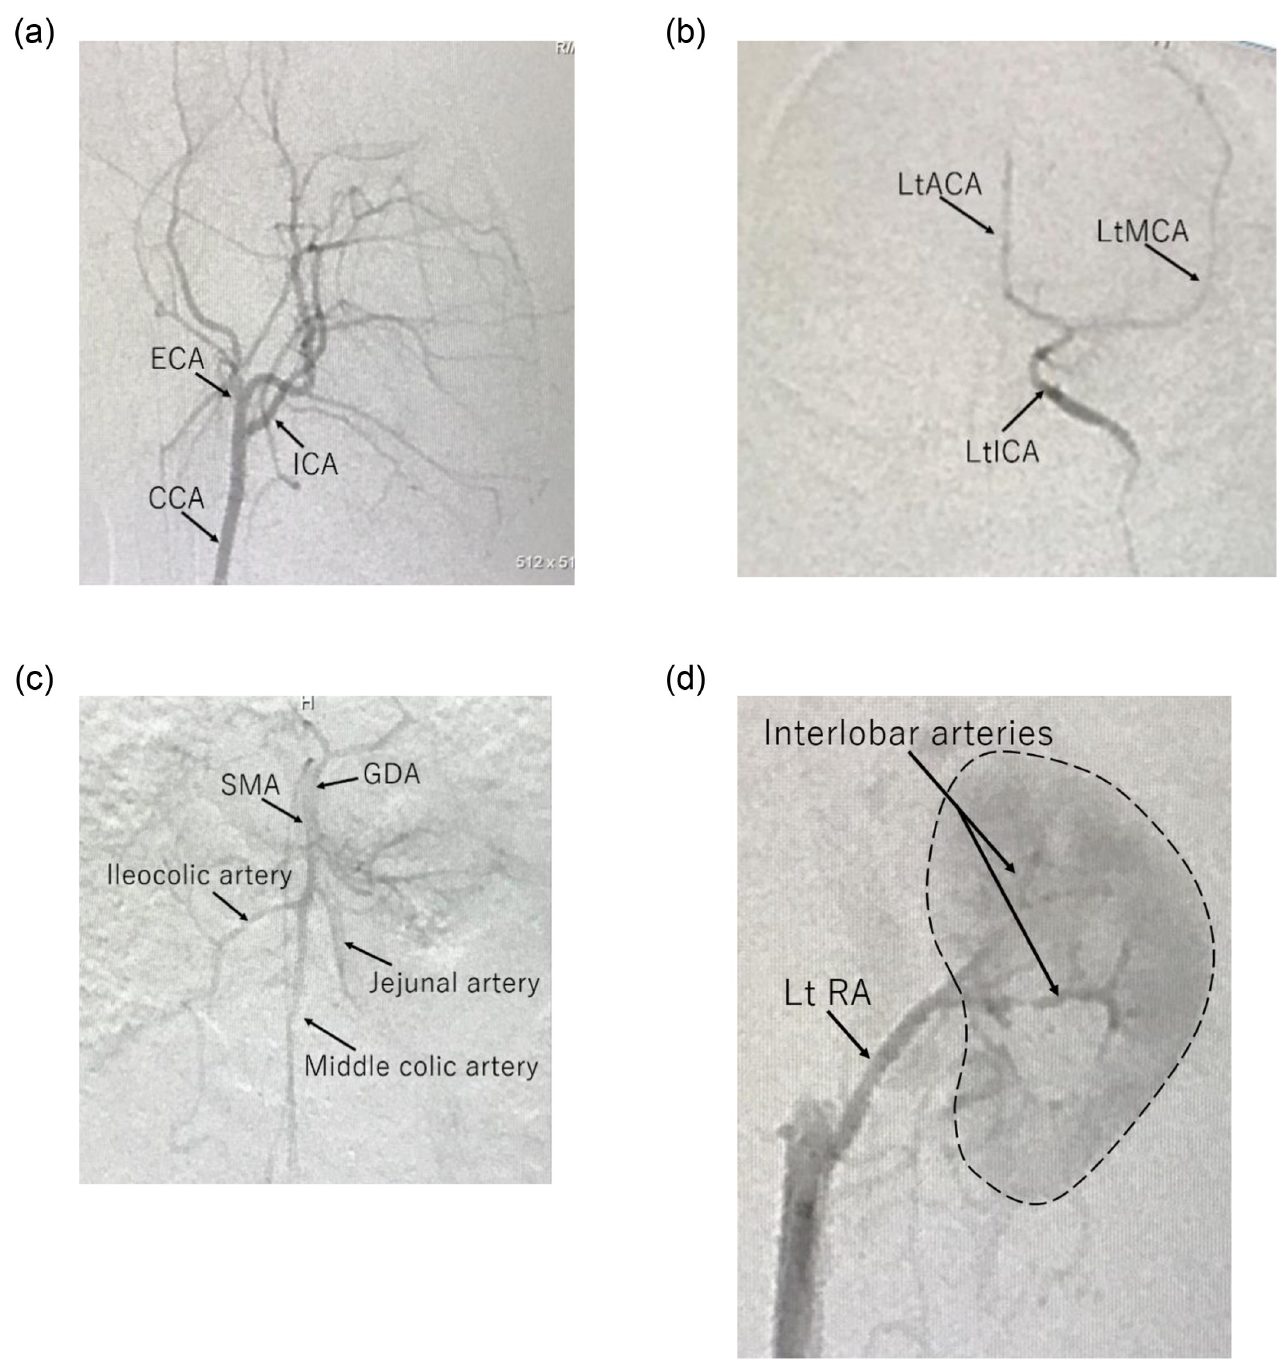
Fig 2. Marmoset angiography. (a) CCA angiography of a marmoset. (b) Angiographic images of selective cannulation into the left internal carotid artery (ICA) with frontal view in the marmoset. (c) The SMA was cannulated with wires and microcatheters, and angiography was performed by injecting a contrast agent through the tip of the microcatheter located at the origin of the SMA in the marmoset. Marmosets showed good visualization of the first bifurcation up to the periphery of the SMA. (d) Wires and microcatheters were cannulated in the RA based on the results of abdominal aortography, as well as the SMA procedure, and selective angiography was performed in the marmoset. Detailed vascular information was obtained up to the interlobar RA. Using a thin microcatheter, more peripheral cannulation and super-selective angiography were successfully performed.